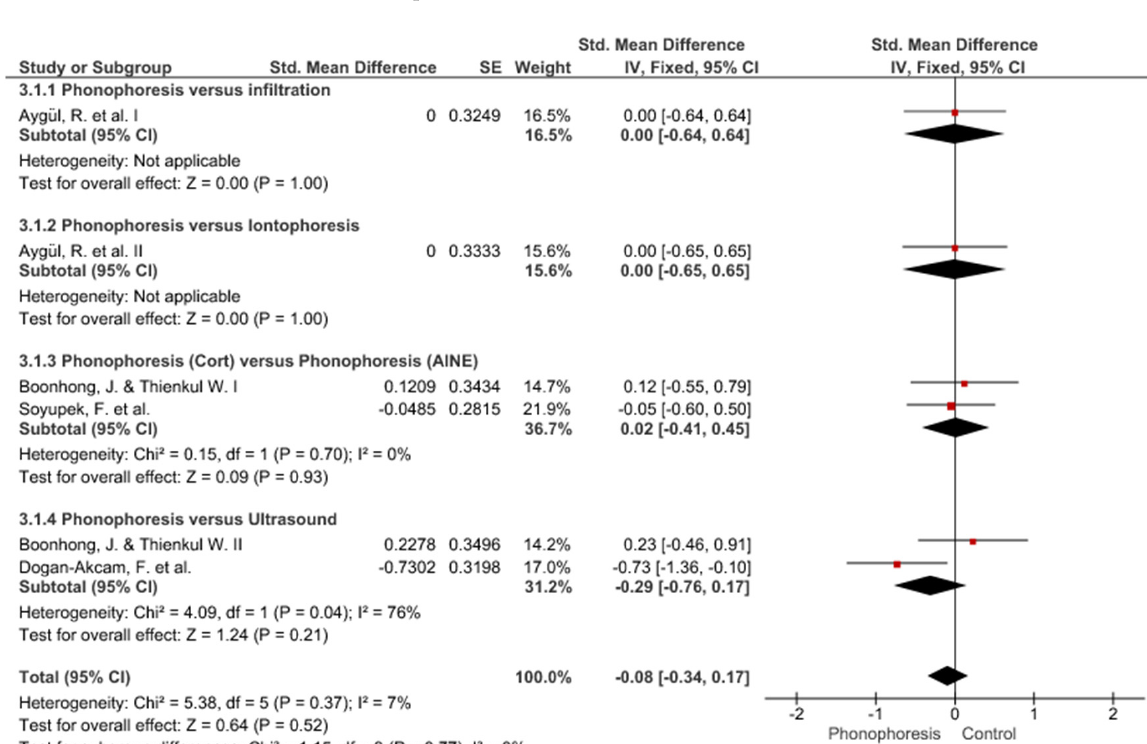
Figure 3. Phonophoresis for BCTQ Sensorial.